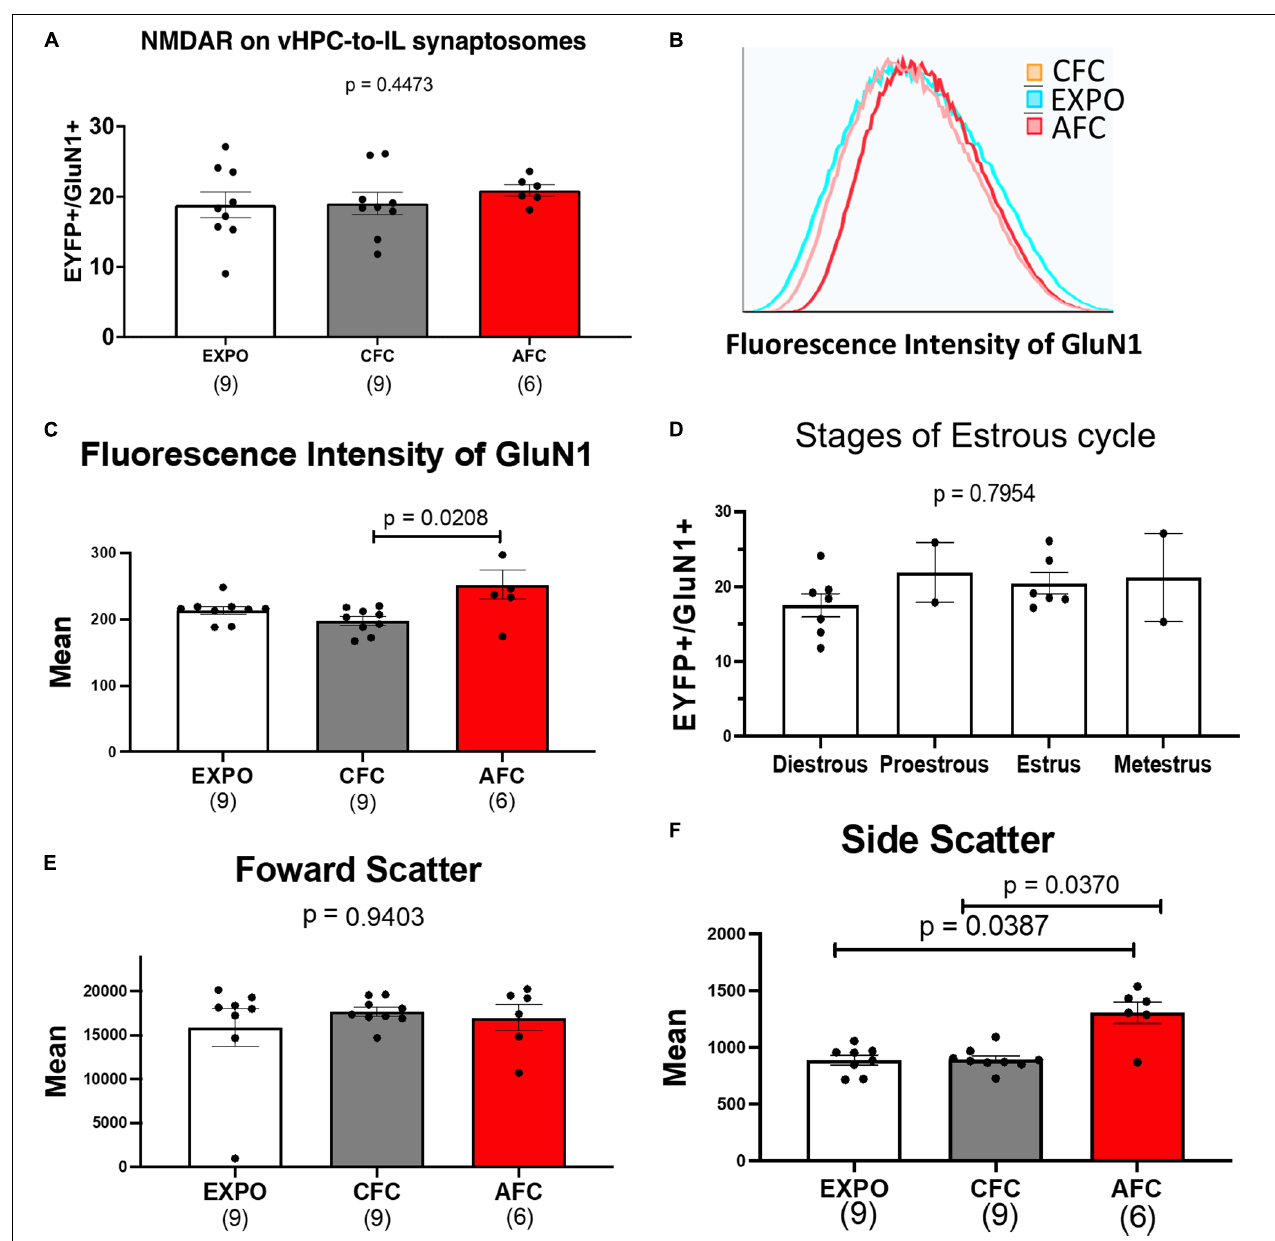
FIGURE 4 | AFC does not alter GluN1 expression at vHPC-IL synaptosomes in females. (A) Relative levels of EYFP+/GluN1+ synaptosomes in female behavioral groups. (B) Representative histogram of the fluorescence intensity of GluN1 on EYFP+/GluN1+ synaptosomes from a single sample from the EXPO, CFC, and AFC female groups. (C) Mean fluorescence intensity of GluN1 on EYFP+/GluN1+ synaptosomes in female groups. (D) Mean fluorescence intensity of GluN1 on EYFP+/GluN1+ synaptosomes across the estrous cycle. (E) Mean forward scatter of the EYFP+/GluN1+ synaptosomes in the female groups. (F) Mean side scatter of the EYFP+/GluN1+ synaptosomes in the female groups. Sample sizes are indicated below each